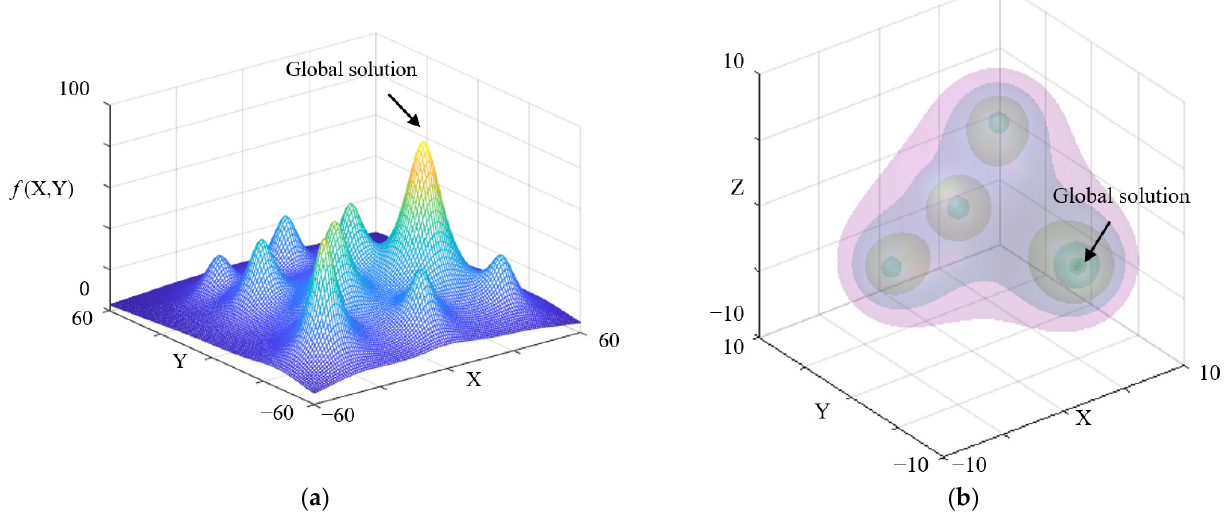
Figure 4. Mathematical test functions ( a ) Test function 1 with 2 variables; ( b ) Test function 2 with 3 variables.